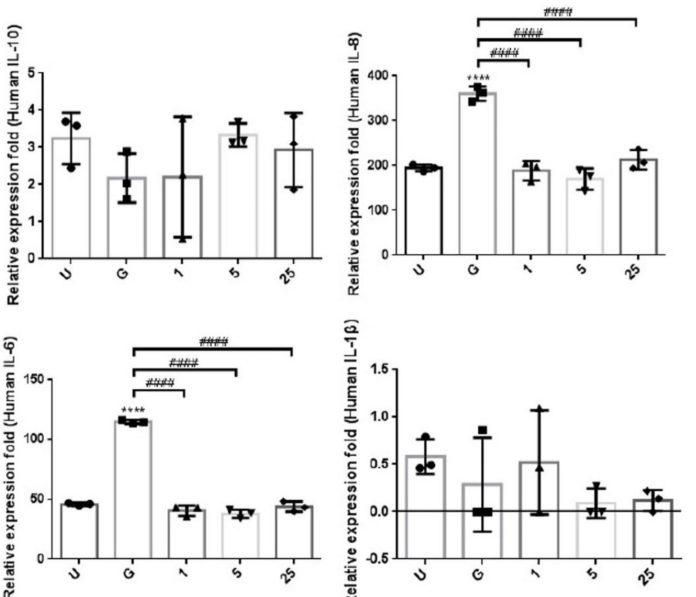
Figure 5. LCN2 suppressed the secretion of inflammatory cytokines in UPEC-infected bladder cells. SV-HUC-1 cells were first pretreated with 15 mM glucose, followed by treatment with different con- centrations of LCN2 (1, 5, and 25 µ g/mL) for 24 h and infection with pGFP-UPEC (MOI of 1:100) for 4 h, as described in the text. The definitions of the letters on the X axis: U, UPEC infection alone; G, with 15 mM glucose pretreatment alone. The release levels of cytokines IL-8, IL-10, IL-1 β , and IL-6 from UPEC-infected SV-HUC-1 cells were measured by CBA. Cells infected with UPEC alone (MOI of 1:100) were used as positive controls. The data are expressed as means ± SDs from three separate experiments. An analysis of variance was used to evaluate differences between various treatment groups and controls. Statistical differences between groups were determined using the Mann–Whitney U Student’s t -test. Statistical significance was set at p < 0.05. **** p < 0.0001 compared to the positive control groups. #### p < 0.0001 for comparisons between two